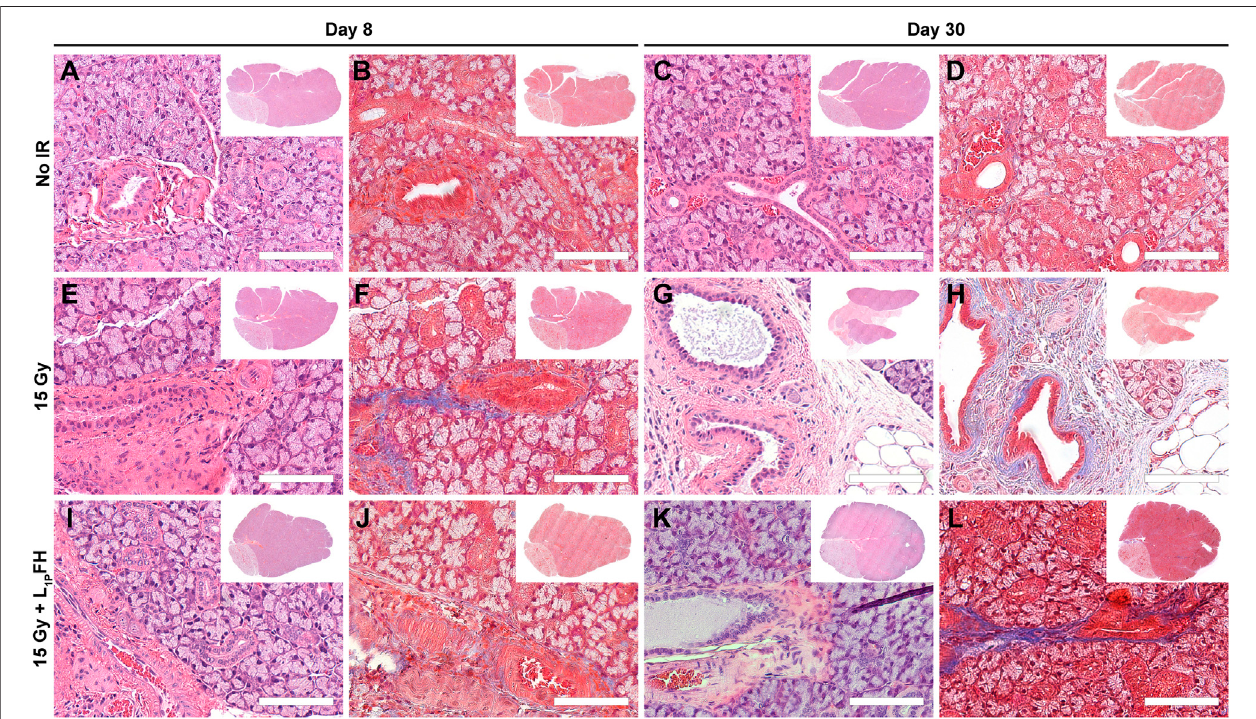
FIGURE 2 | Treatment with L 1p -FH preserves epithelial integrity when applied after radiation treatment. Hematoxylin and eosin (A,C,E,G,I,K) as well Masson ’ s trichrome (B,D,F,H,J,L) staining of mouse submandibular glands from group 1 [non-irradiated, (A – D) ], group 2 [irradiated without L 1p -FH injection, (E – H) ] and group 3 [irradiated with L 1p -FH injection, (I – L) ] were performed and tissue morphology was analyzed using a Leica DMI6000B. Scale bars represent 100 µm. Representative image from a total of fi ve mice per